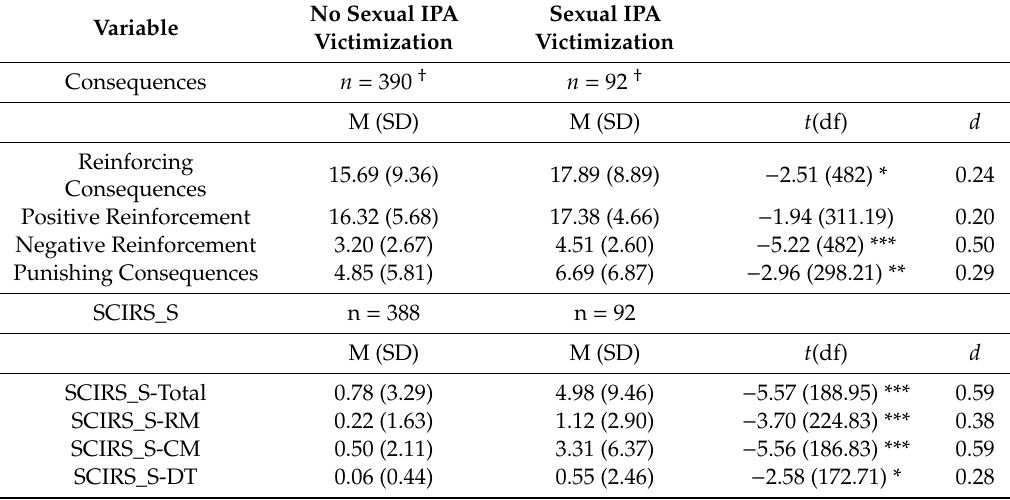
Table 5. Di ff erences in Sexting Consequences and Sexual Coercion Based on Sexual IPA Victimization